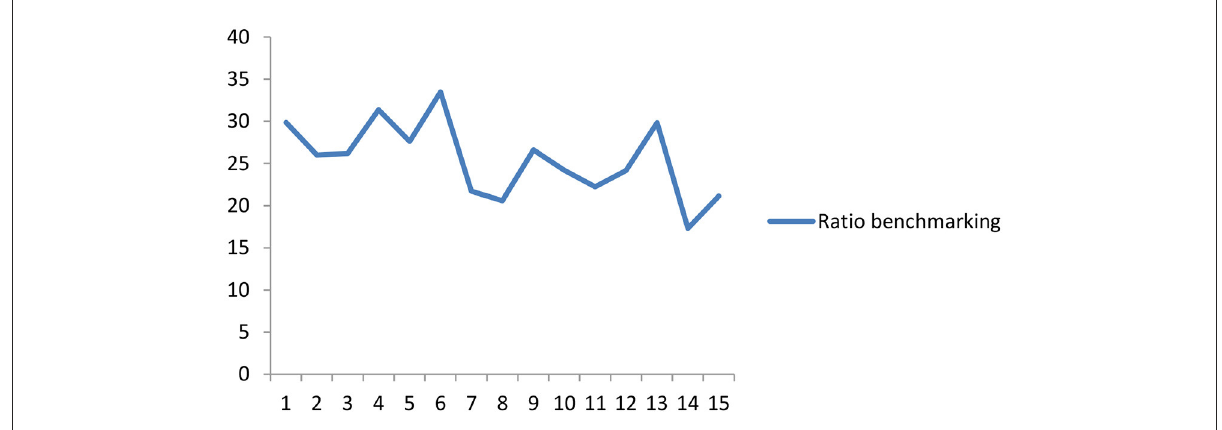
FIGURE5 Plot of OPREM Gold Impact Factor